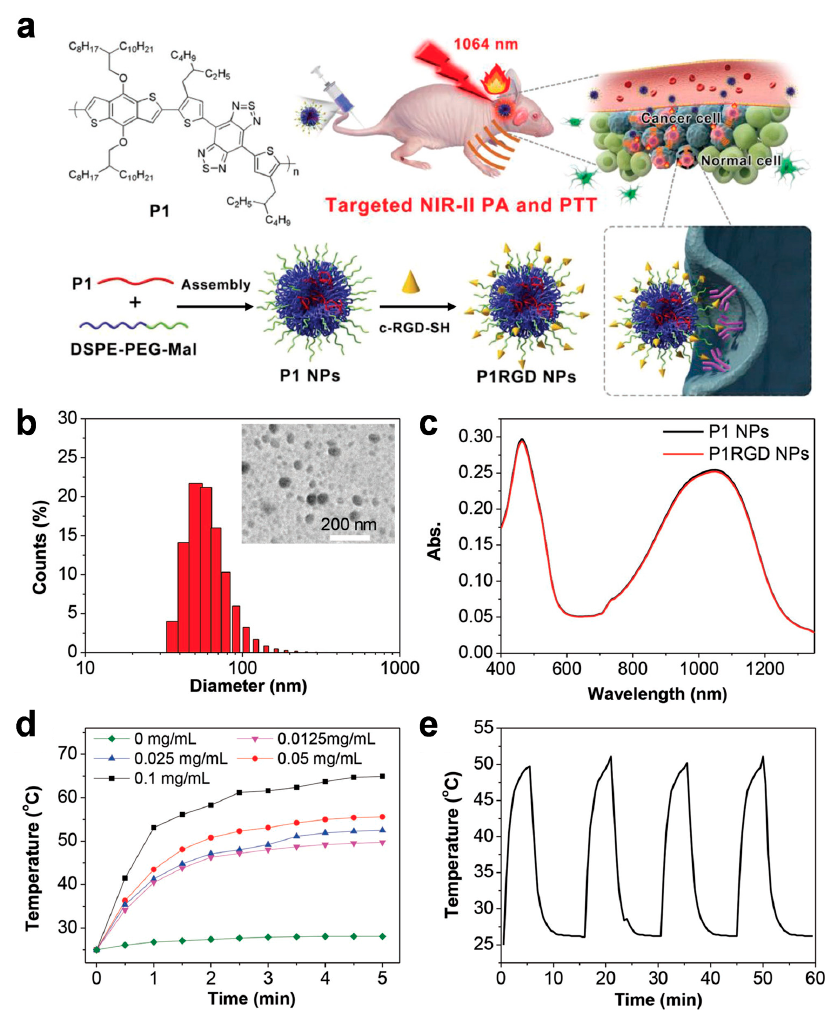
Figure 15. ( a ) Illustration of nanoparticle fabrication and in vivo brain tumor photothermal therapy and photoacoustic imaging. ( b ) Dynamic light scattering (DLS) data and transmission electron microscopy (TEM) image of P1RGD NPs. ( c ) UV–Vis spectra of P1 NPs and P1RGD NPs, respectively. ( d ) Photothermal heating effects of P1 NPs at different concentrations under a 1064-nm